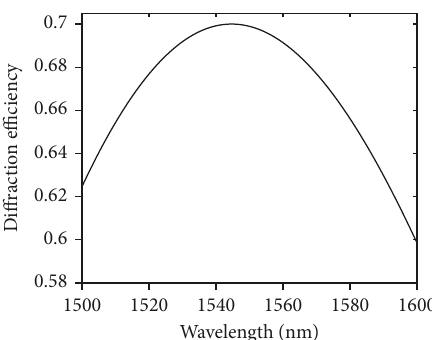
Figure 3: Diffraction efficiency as a function of